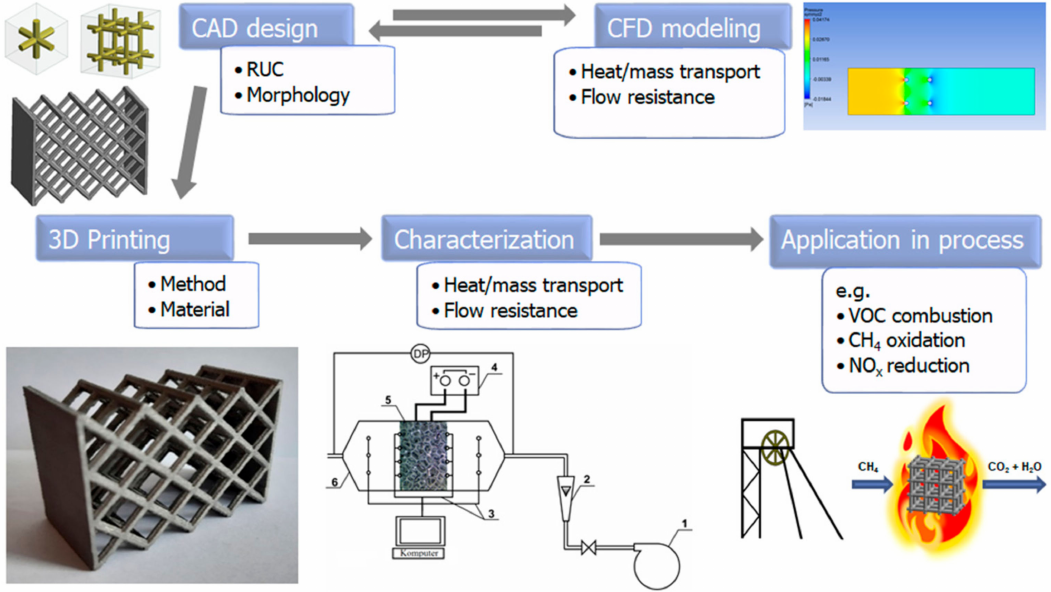
Figure 12. Scheme of